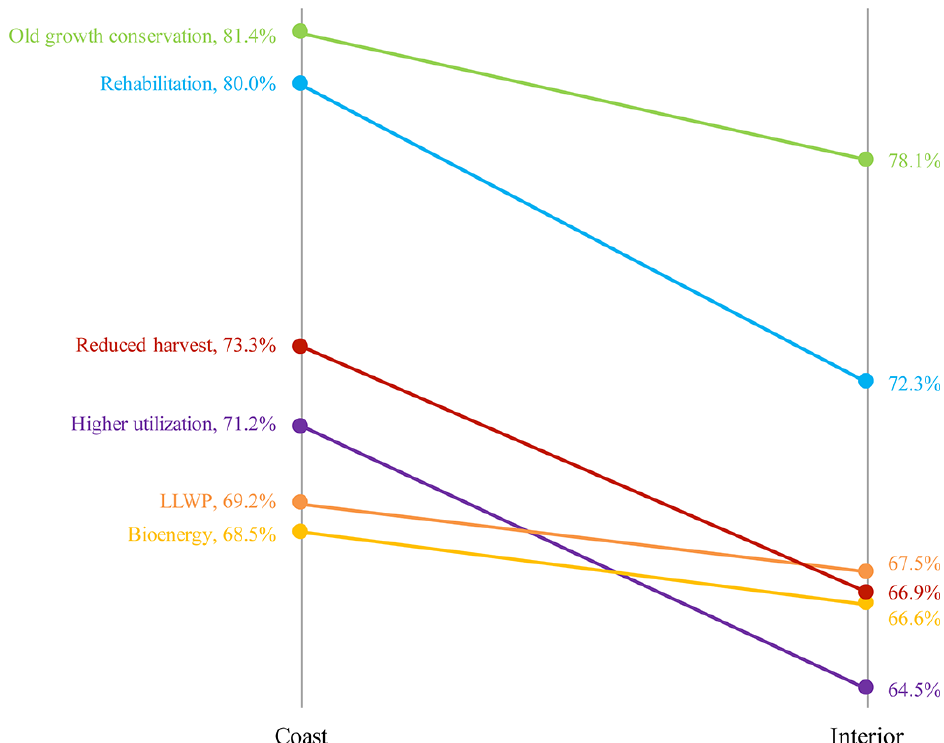
Figure 7. Average cumulative derived preference for the six strategies on the coast and the interior. The derived preference of each strategy was calculated by summing, for each objective, the product of the average performance of a strategy against an objective (Figures 6 and 7) with the weight of this objective (Figure 5). The resulting score was transformed into a percentage by dividing it with the maximum possible score of a strategy.